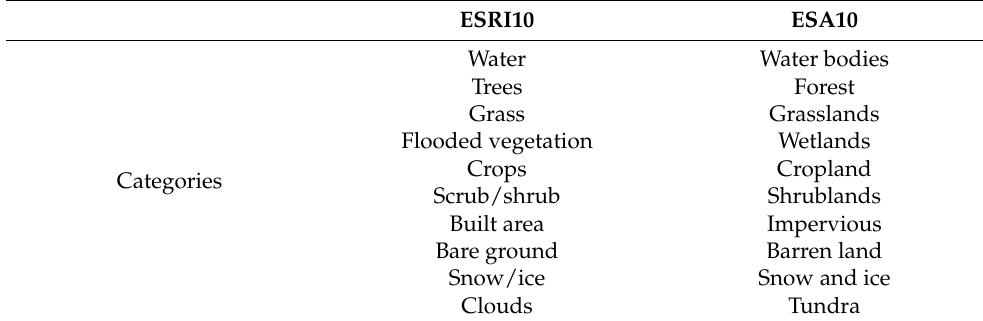
Table 7. The classification system of ESRI10 and ESA10.